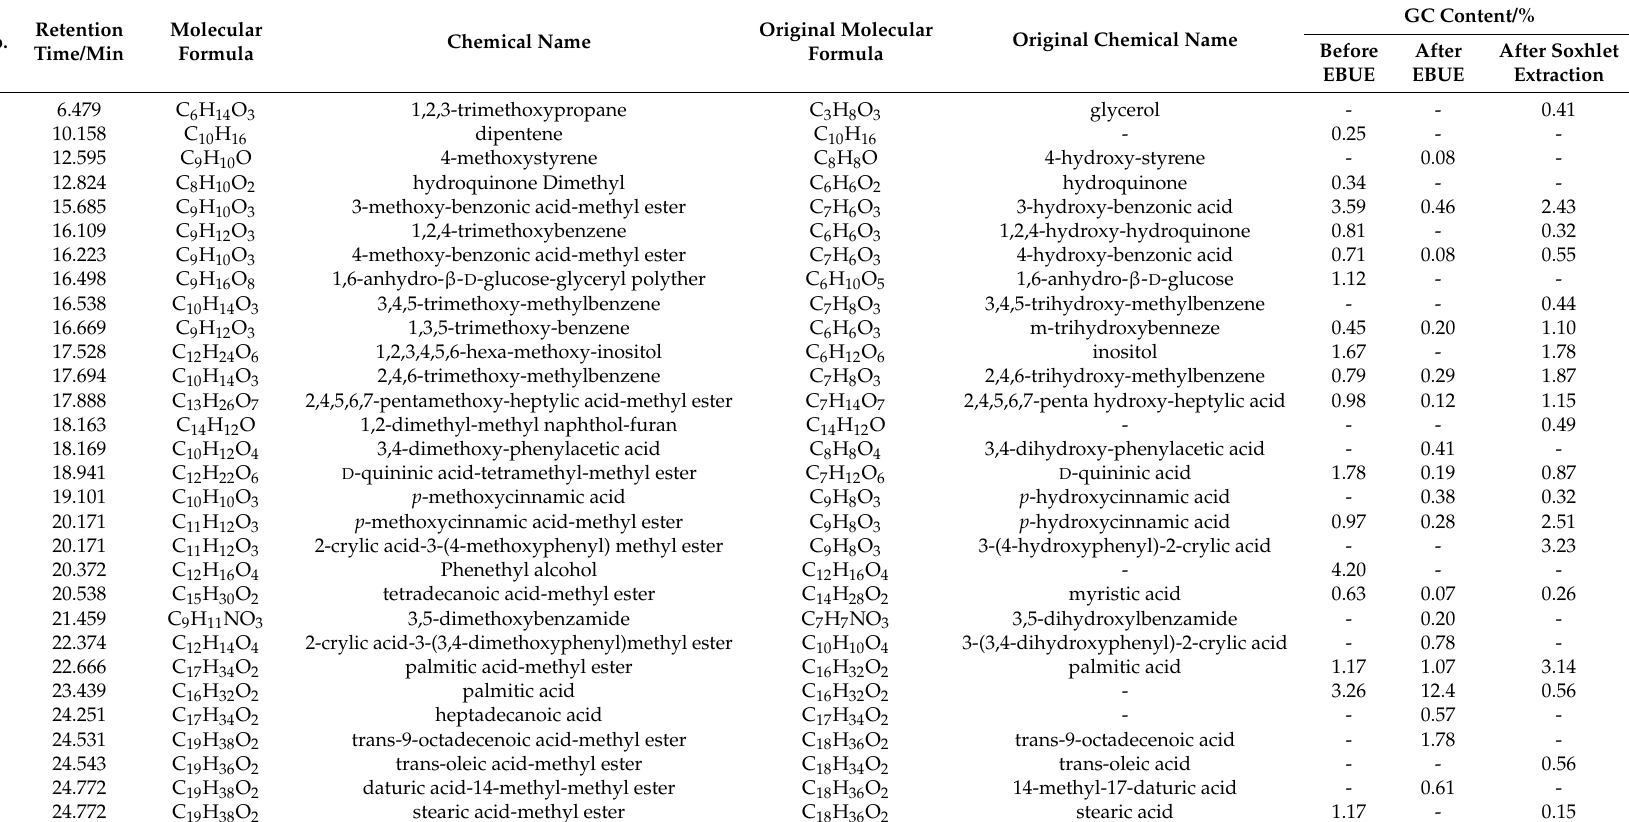
Table 2. Pyrolytic products for Ginkgo biloba leaves (GBL) before and after EBUE as well as after Soxhlet